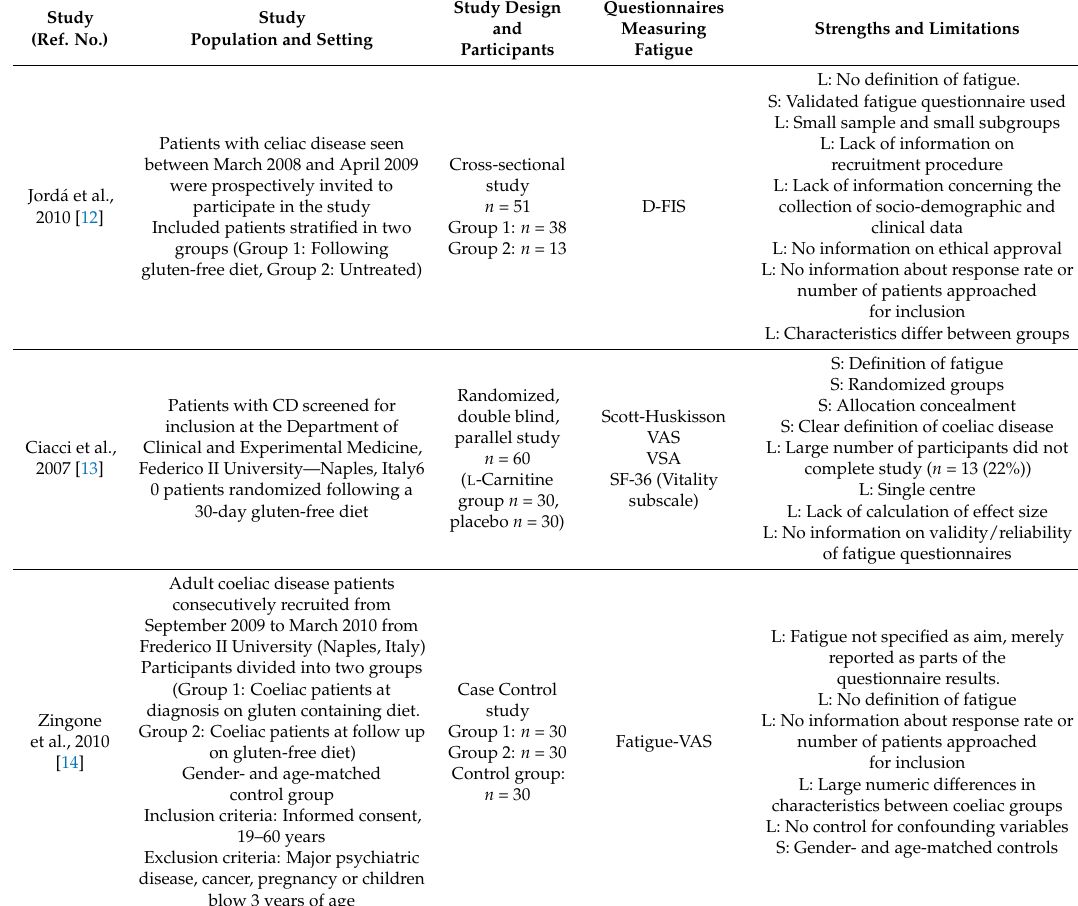
Table legends and abbreviations: L; Limitation., S; Strength., SF-36; Short Form-36 Health Survey., D-FIS; Daily Fatigue Impact Scale., FSS; Fatigue Severity Scale., CFS; Chronic Fatigue Syndrome Questionnaire., GBB-24., Geißener Symptom Check List., VSA; Verbal Scale for Asthenia, VSA. CD; Coeliac disease, HADS-D; Hospital anxiety and depression scale –